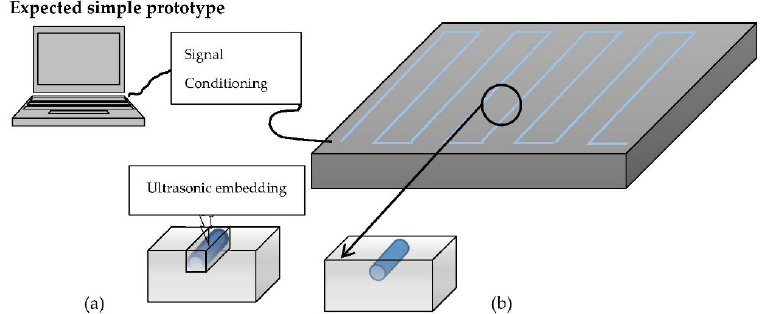
Figure 4. Design concept of aluminum embedded with FBG sensors: ( a ) glueing and ( b ) ultrasonic embedding.